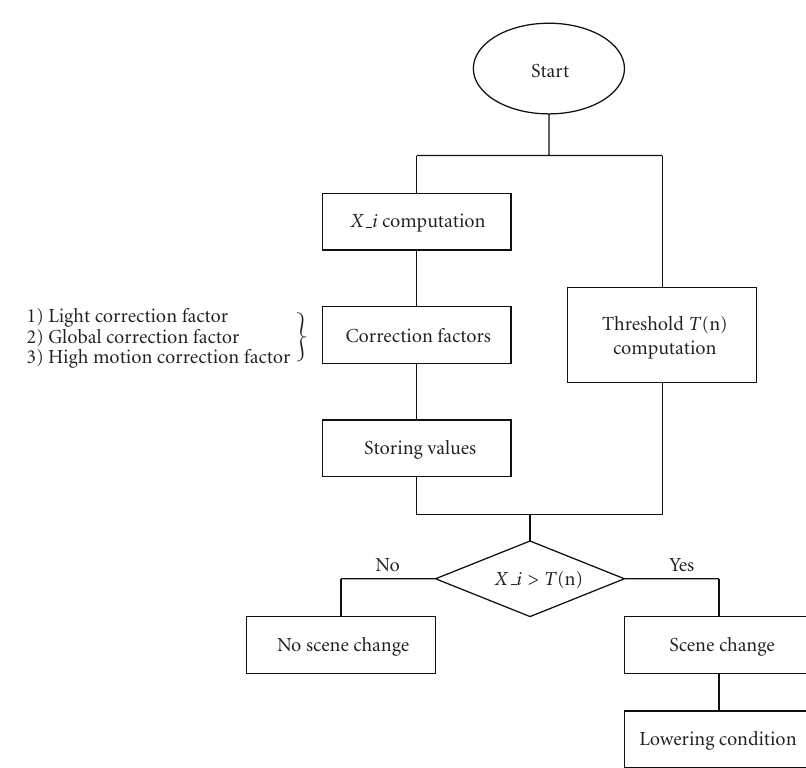
Figure 9: The scene change detector main components and processing flow.